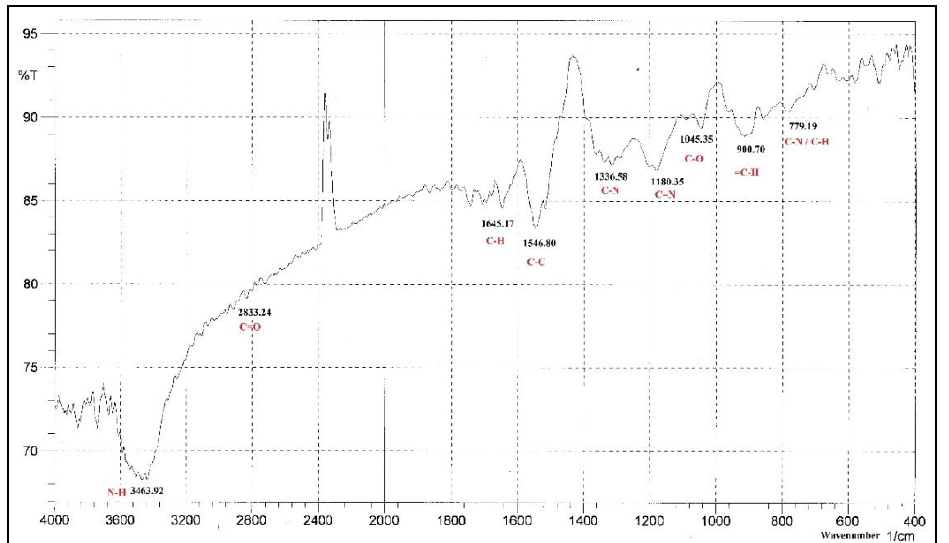
Fig.8: (b) FTIR spectra of PPy with (3%) of GN nanocomposite.